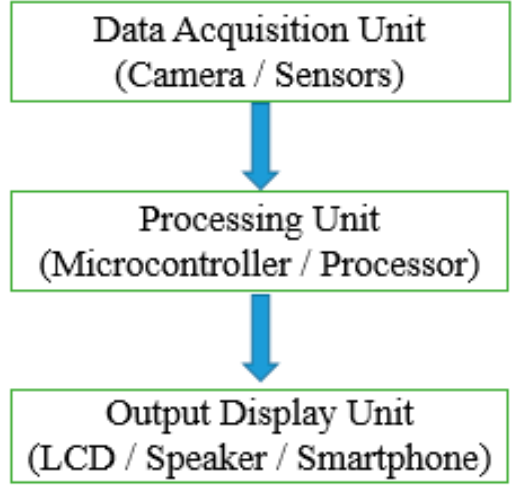
Figure 4. Sign recognition